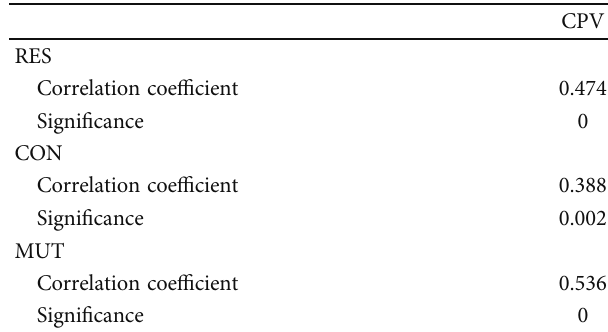
Table 6: Correlation analysis of interactivity and